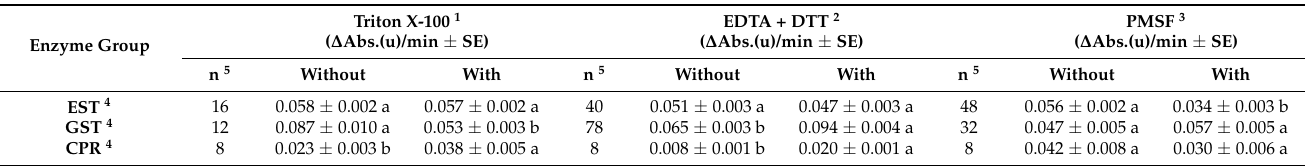
Table 2. Influence of additives on reaction rate in esterase (EST), glutathione S-transferase (GST) and cytochrome P450 reductase (CPR) activity